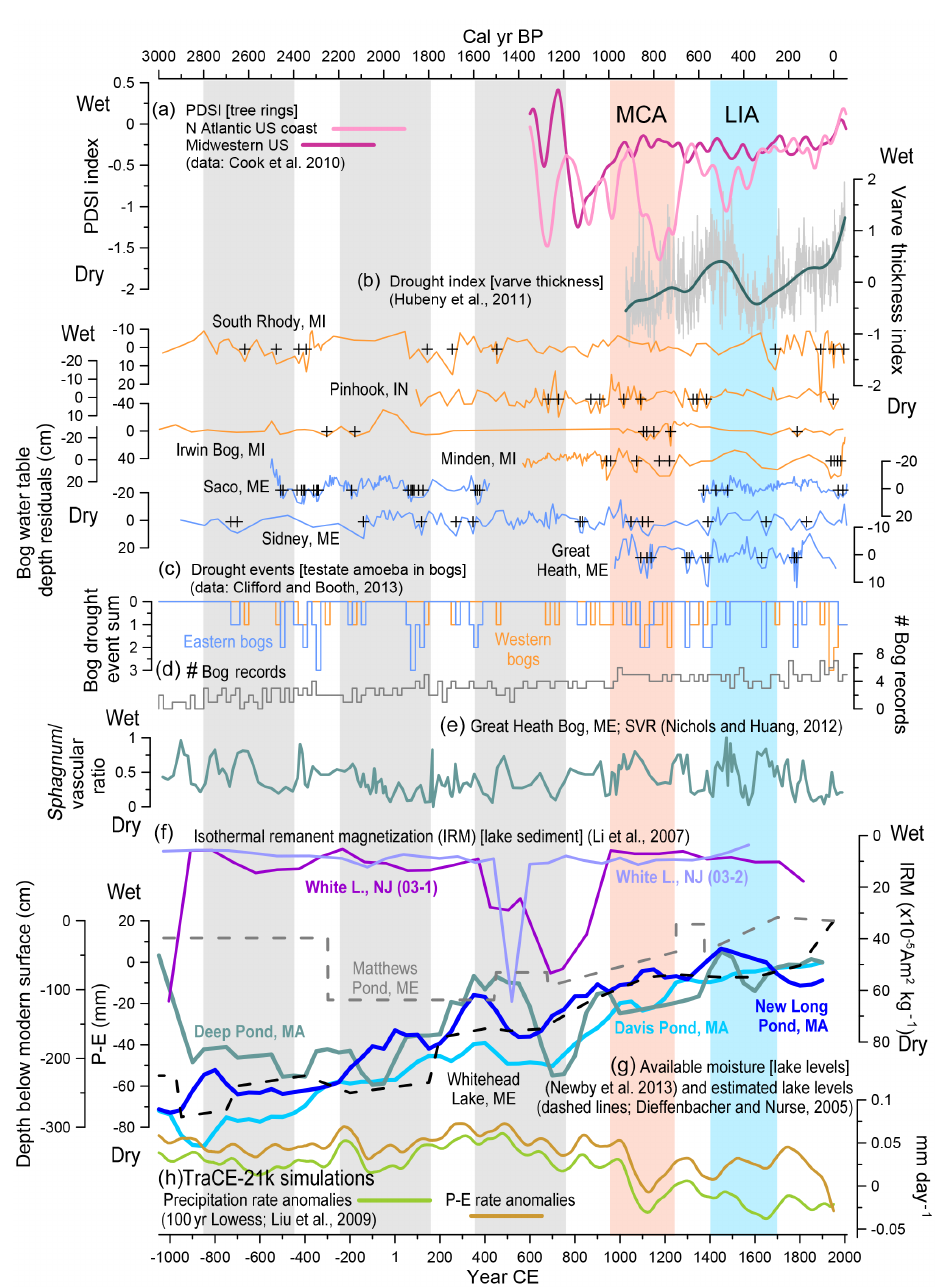
Figure 7. Hydroclimatic reconstructions for the last 3000 years for the NE US and adjacent regions, sourced from diverse paleoclimatic proxies and archives. (a) Tree-ring-based reconstructions of PDSI (Cook et al., 2010); (b) composite index of two varve thickness records from Green Lake, New York, and the Pettaquamscutt River Estuary, Rhode Island (Hubeny et al., 2011); (c) drought events (marked with “+”) and event summary based on water table reconstructions from testate amoeba in western kettle-hole peatlands (Pinhook and South Rhody), western bogs (Irwin Smith and Minden), and eastern bogs (Sidney, Saco, and Great Heath; Booth and Jackson, 2003; Booth et al., 2006, 2012; Clifford and Booth, 2013); (d) bog record counts; (e) ratio of Sphagnum to vascular plants from the Great Heath Bog, Maine (Nichols and Huang, 2012); (f) drought indicator based on isothermal remanent magnetization at White Lake, New Jersey (Li et al., 2007); (g) lake level reconstructions from Deep, Davis, and New Long ponds in Massachusetts (Marsicek et al., 2013; Newby et al., 2014) and lake level change estimates from Mathews Pond and Whitehead Lake, Maine (Dieffenbacher-Krall and Nurse, 2005); and (h) precipitation and P - E rate anomalies from the TraCE-21k simulations (Liu et al., 2009). Vertical gray bands are only provided as a visual aid to identify the timing of features in the records. Pink and blue vertical bars mark the well-known MCA and LIA